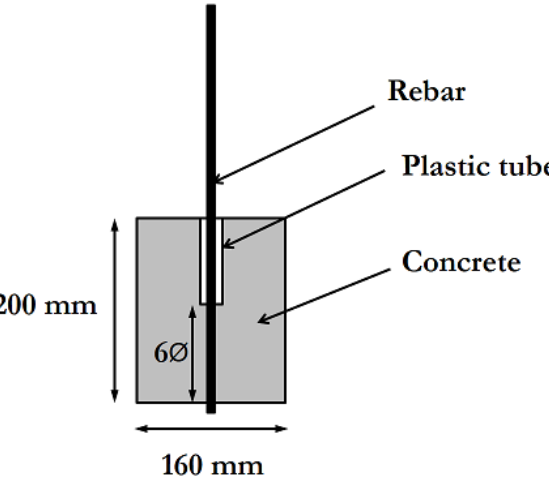
Figure 3. Geometry of the specimens used for pull-out tests.